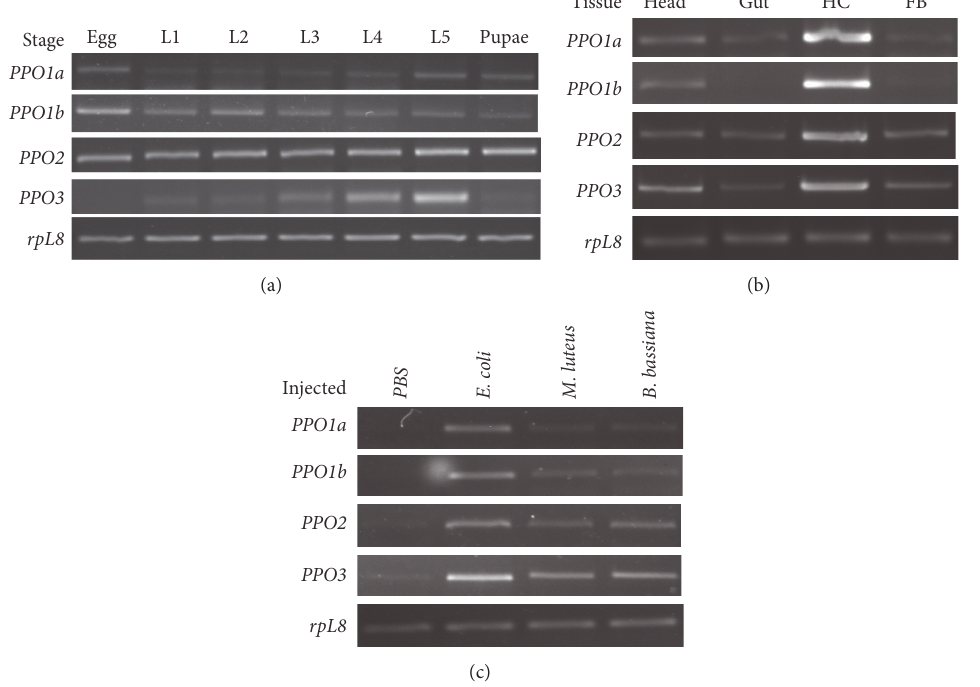
Figure 5: RT-PCR analysis of the expression of four O. furnacalis PPOs . (a) Expression profiles of OfPPOs at different stages of development. RNA was extracted from the whole bodies collected from eggs, first-instar ( L1 ), second-instar ( L2 ), third-instar ( L3 ), fourth-instar ( L4 ), fifth- instar ( L5 ) larvae, and pupae. The rpL8 was used as an internal control. (b) Expression patterns of OfPPOs in different tissues of O. furnacalis larvae. Tissues including head, gut, hemocytes (HC), and fat bodies (FB) were collected from day-zero, fifth-instar larvae for RNA extraction. RT-PCR was performed to assess the transcript level of OfPPOs . The rpL8 was used to normalize the templates. (c) Expression profiles of PPOs in O. furnacalis larvae upon microbial challenge. Day 1, fifth-instar larvae were infected with water, E. coli , M. luteus , or B. bassiana . RNA was prepared from the whole bodies 24 h after injection. RT-PCR was used to analyze the transcript change of OfPPOs . The rpL8 was used as an internal standard to indicate a consistent total mRNA